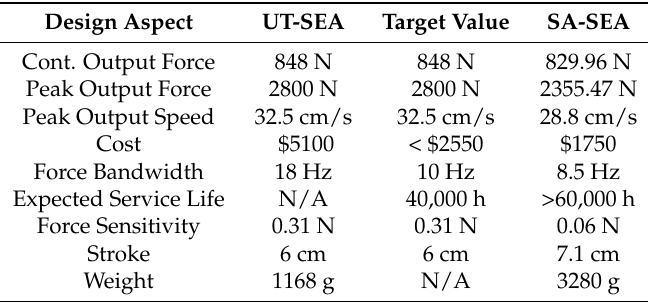
Table 1. Properties of the UT-SEA [26], our design goals and achieved properties of the SA-SEA. Design